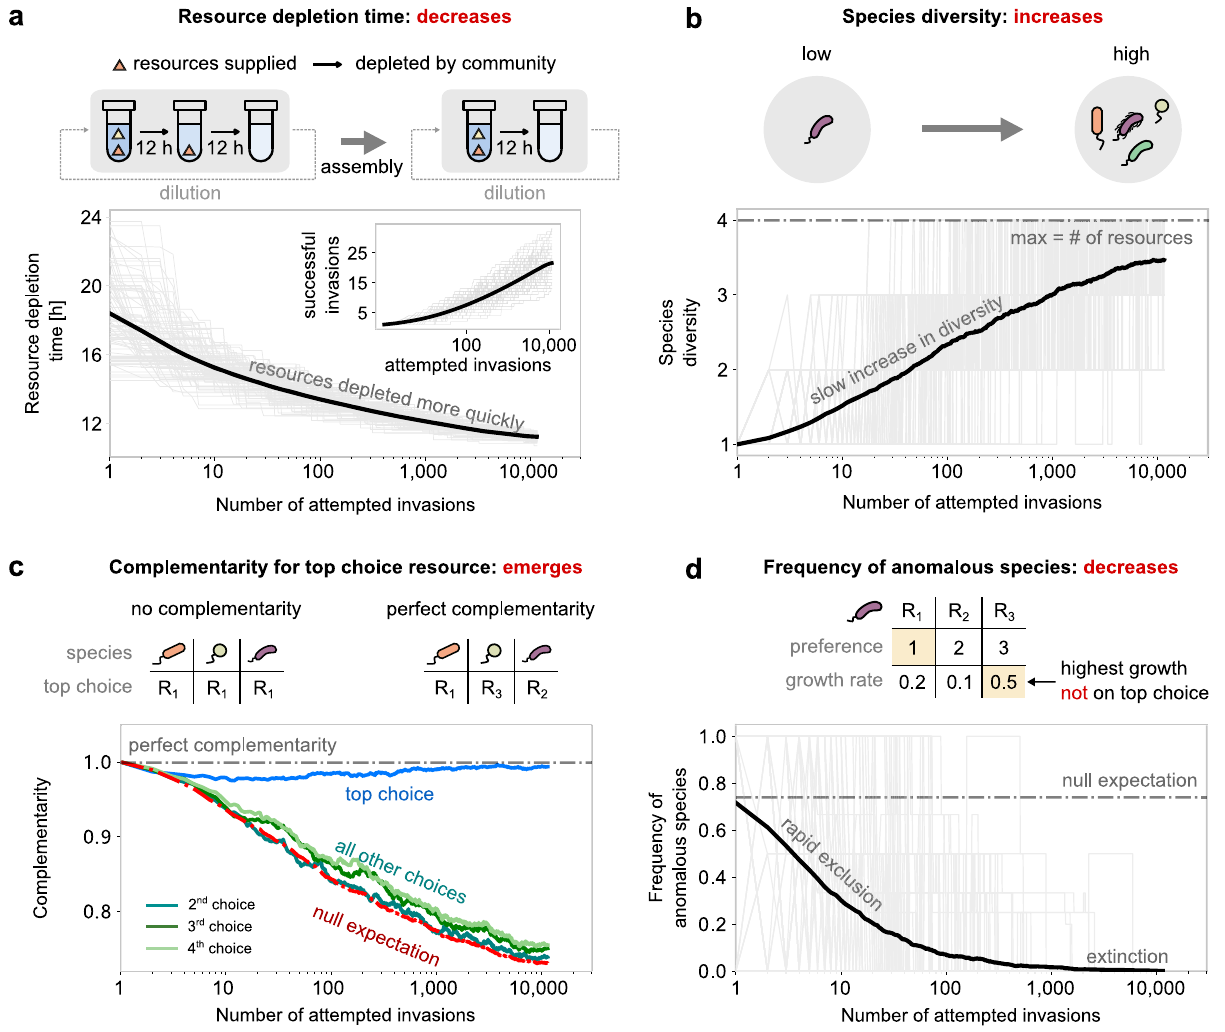
Fig. 2 Emergent properties of diauxic microbial communities. In all plots, solid bold lines represent the average over 958 individual community assembly simulations, while gray lines correspond to 100 randomly chosen community assembly simulations. a Total resource depletion time during community assembly (the time taken by the community to deplete all available resources). (Inset) Number of successful invasions during community assembly. b Total species diversity during community assembly (number of surviving species at steady state). c Resource utilization complementarity during community assembly. For each time point, the n th choice complementarity was calculated as a number of unique resources among the n -th preferred choices of all species in the community, divided by the number of unique resources in the environment. For a certain community, the null expectation (complementarity without selection) was de fi ned by the complementarity of a random set of species from the pool that has the same diversity of that community. Colored lines show the average trend of complementarity on each preferred resource choice: top (light blue), second (cyan), third (deep green), and fourth (light green). The red dash-dotted line shows the average trend of null expectation. The gray dash-dotted line at the top corresponds to the perfect complementarity, which is 1. d Frequency of species with anomalous resource preferences during community assembly. The gray dash-dotted line is the expectation of fraction of anomalous species (75%) in the